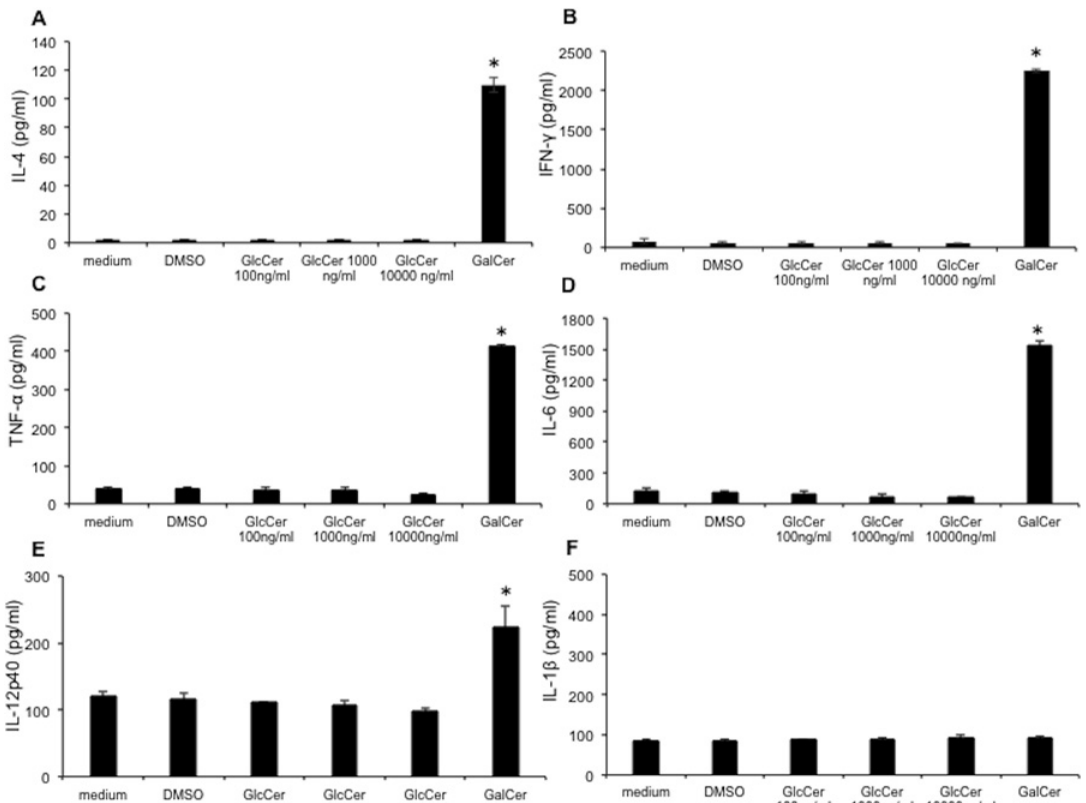
Fig 4. Detection of cytokines in the medium of mice liver mononuclear cells following glycolipid treatment. Detection of A) IL-4, B) IFN- U . C) TNF- α , D) IL-6, E) IL-12p40, and F) IL-1 β . Plots are the result of ELISA experiments performed on the media of cells after 48 hours of incubation with various concentration of β -GlcCer or 100 ng/ml of α -GalCer. * P < 0 . 05 , GalCer versus medium, DMSO or GlcCer